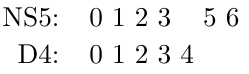
Figure 3 . U(3) pure gauge theory. The distance x 4 = 1 =g 2 direction is the instanton counting parameter. Coordinates of D4 branes in the ( x 5 ; x 6 ) plane set the corresponding Higgs